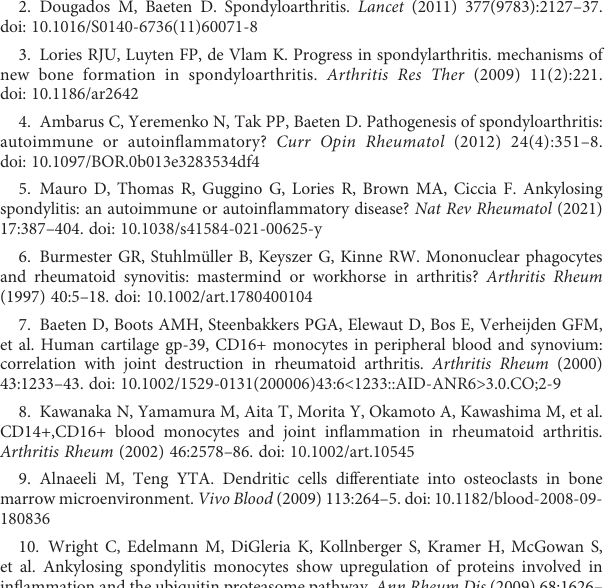
SUPPLEMENTARY FILE 3 Full list of miRNAs examined in this study. SUPPLEMENTARY FILE 4 Spreadsheets presenting associations between differentially expressed miRNAs themselves in classical, intermediate and non-classical monocyte. SUPPLEMENTARY FILE 5 Detailed description of principal component analysis of differentailly expresssed